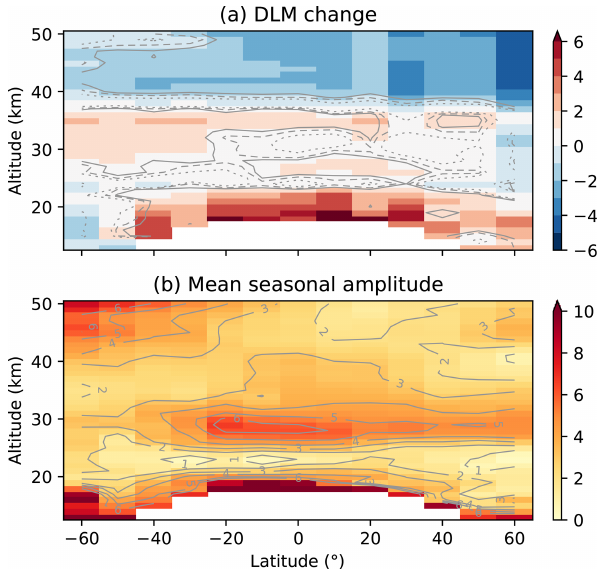
Figure A2. Relative differences in the OSIRIS v7.2 minus v5.10 MZM time series, fitted using DLM, with (a) the percent change between 2002 and 2020 and (b) the amplitude of the fitted seasonal cycle. The dotted, dashed, and solid contours in panel (a) show the 80%, 90%, and 95% confidence intervals,